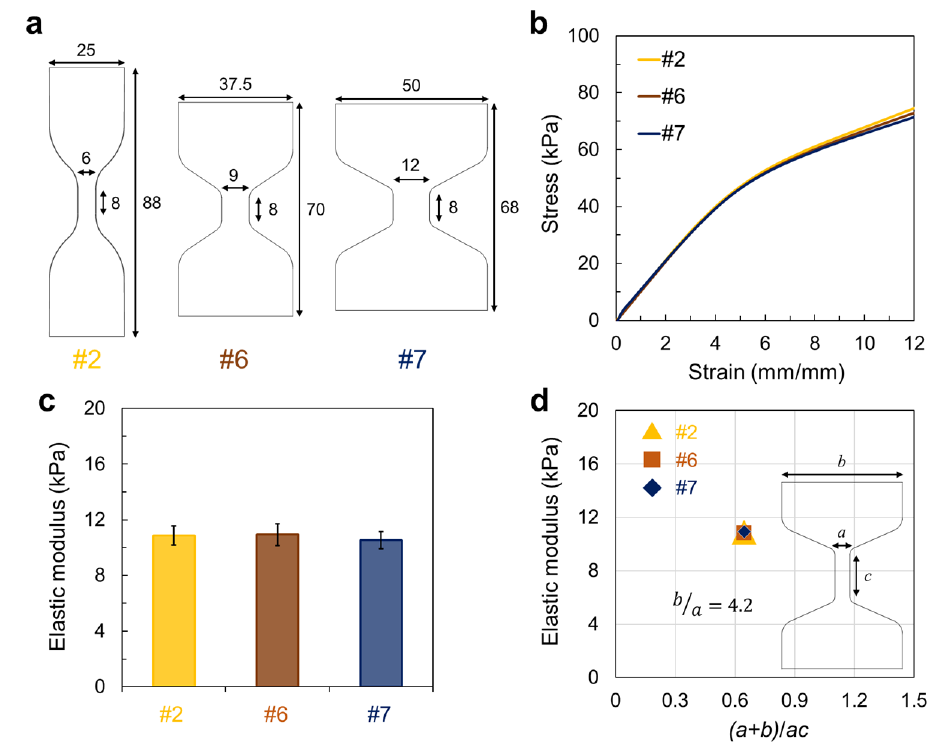
Figure 4. ( a ) Specimen dimensions of three dumbbell shapes with a fixed entire width/narrow width ratio of 4.17 and the same gauge length of 8 mm. ( b ) Stress-strain curve and ( c ) elastic modulus of each hydrogel. ( d ) Elastic modulus value of the hydrogel along ( a + b )/ ac .